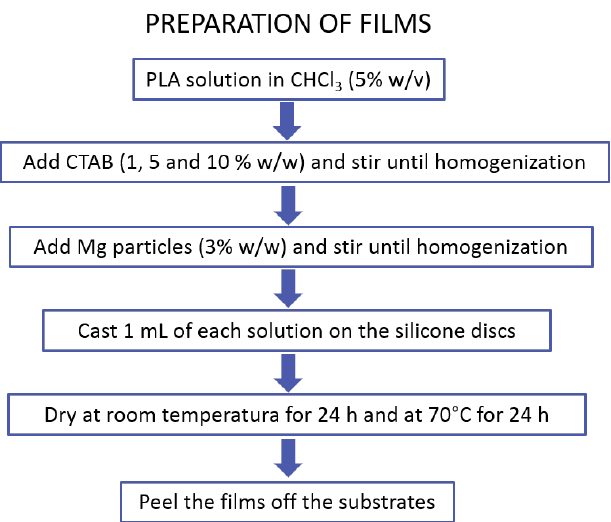
Figure 1. Preparation of films containing CTAB and magnesium particles.